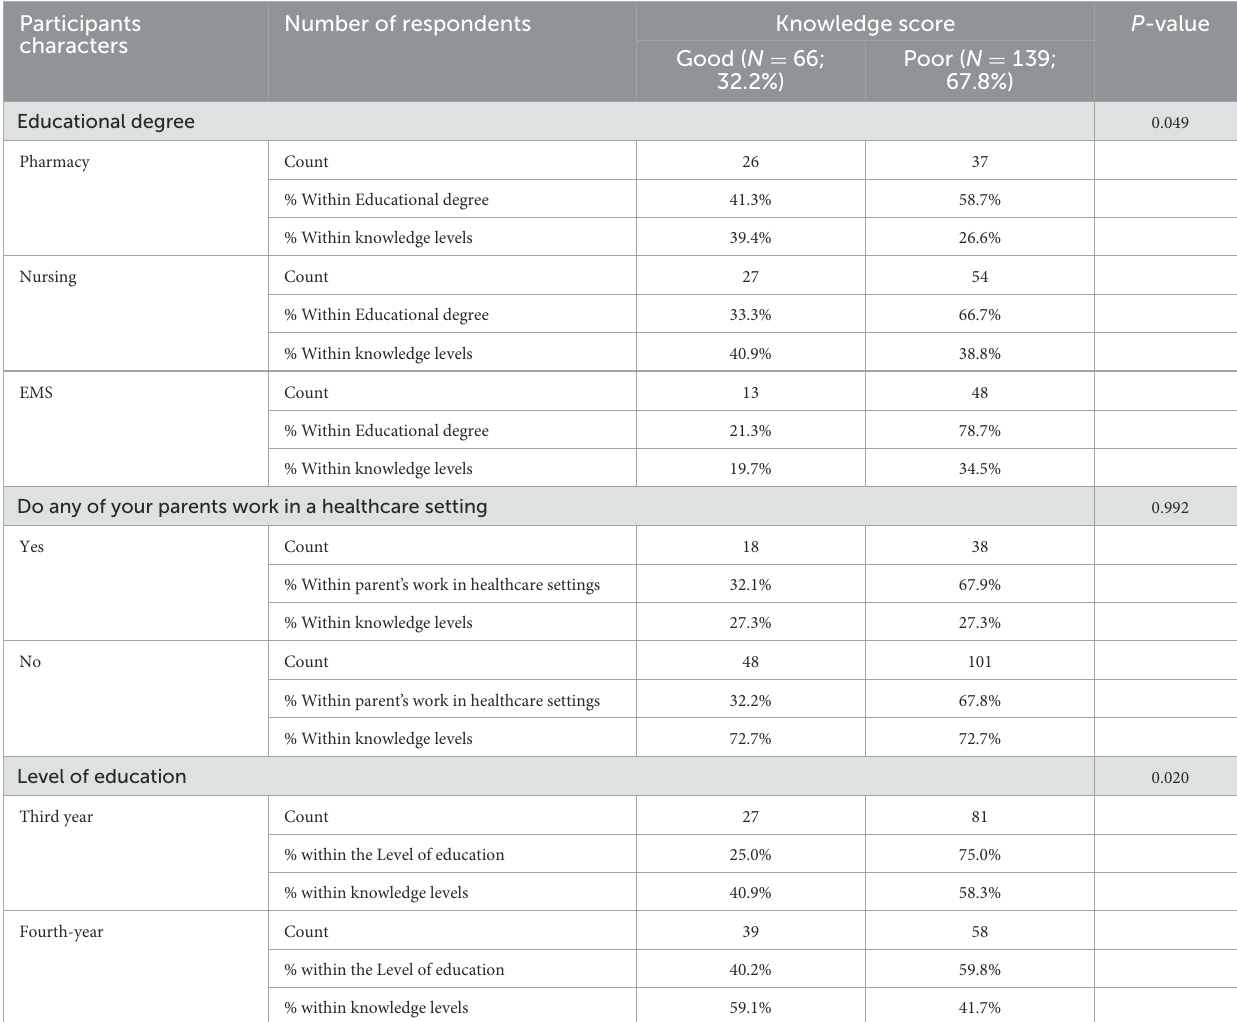
TABLE 5 Association between knowledge score of the participants concerning